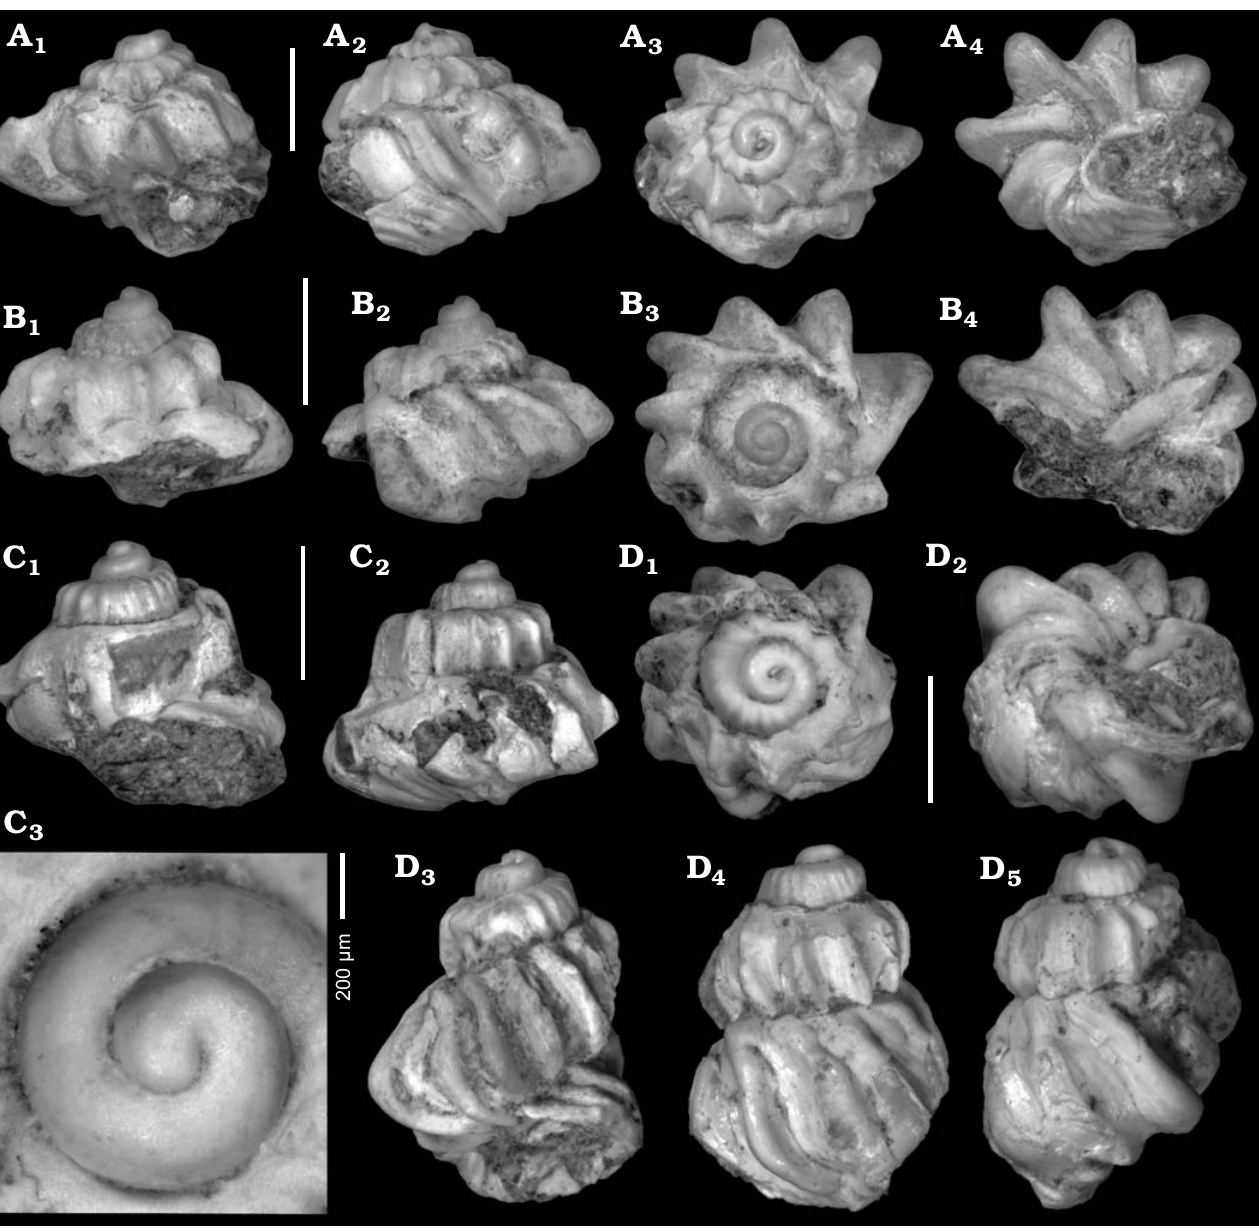
Fig. 4. Valvatid gastropod Valvata koehleri sp. nov. from the upper Oligocene–lower Miocene Susuz Formation, Kömürlü, Turkey. A . NHMW 2018/0019/0018, paratype in apertural (A 1 ), lateral (A 2 ), apical (A 3 ), and umbilical (A 4 ) views. B . NHMW 2018/0019/0016, paratype in lateral (B 1 , B 2 ), apical (B 3 ), and umbilical (B 4 ) views. C . NHMW 2018/0019/0017, paratype in lateral views (C 1 , C 2 ); protoconch (C 3 ). D . NHMW 2018/0019/0015, ho- lotype in apical (D 1 ), umbilical (D 2 ), apertural (D 3 ), lateral (D 4 ), and dorsal (D 5 ) views. Scale bars 2 mm, if not stated